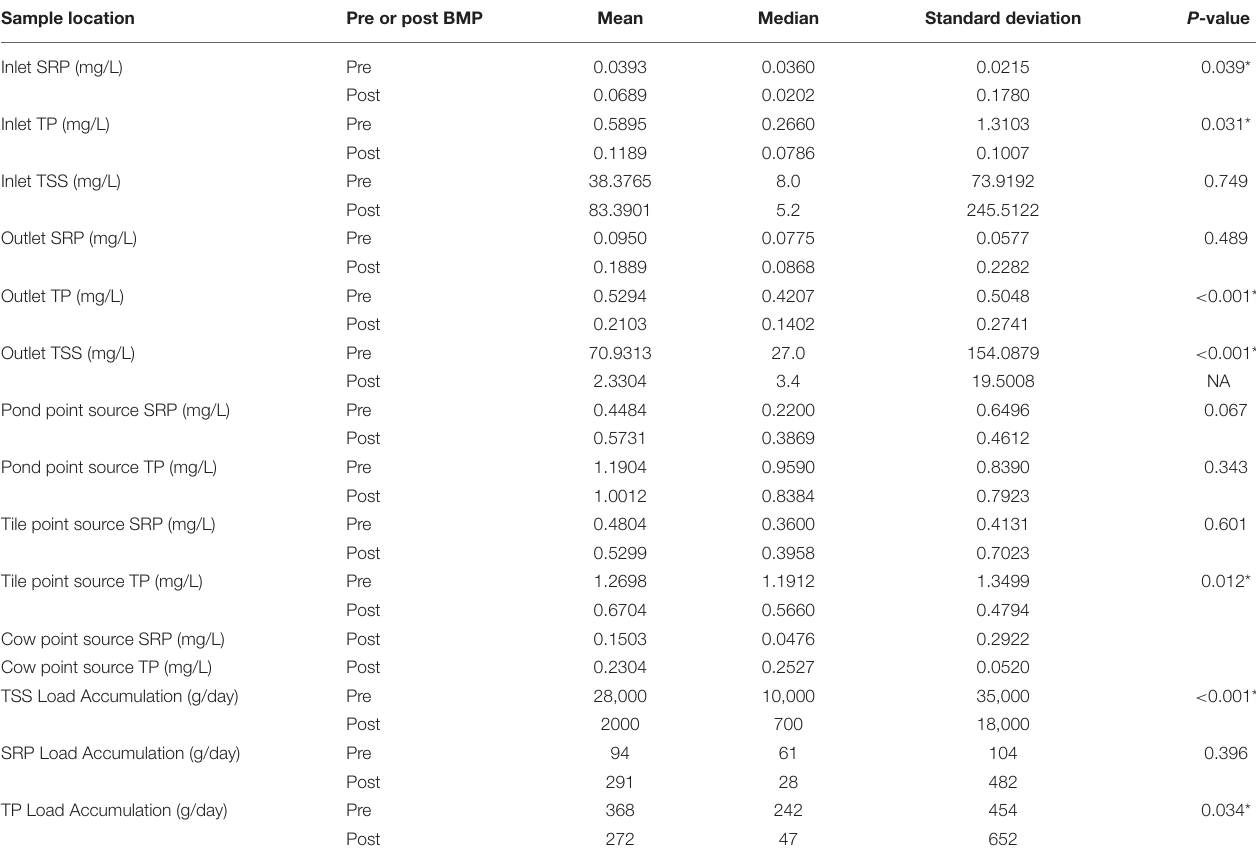
TABLE 2 | Summary statistics for concentrations and accumulated loads for TP, SRP, and TSS; p -values refer to significance in change of observed value between pre and post-BMP